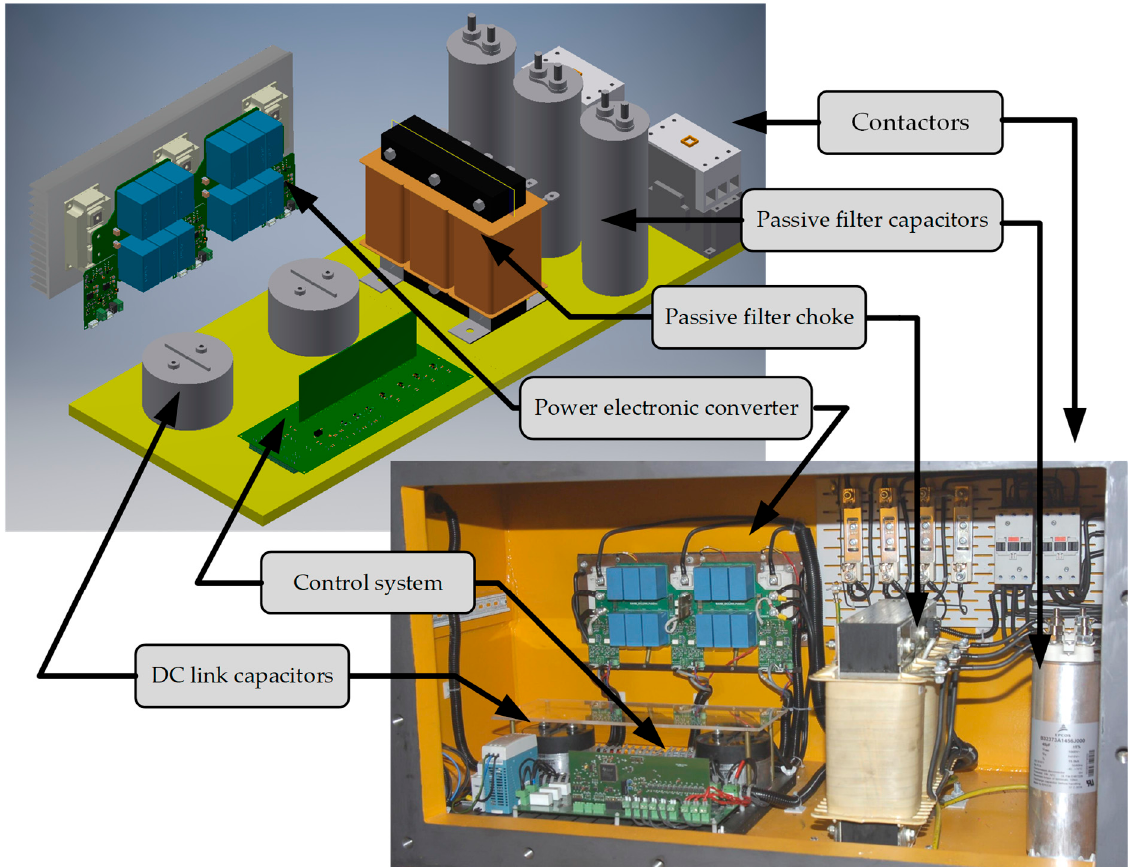
Figure 15. Prototype of hybrid active power filter inside the explosion-proof housing .